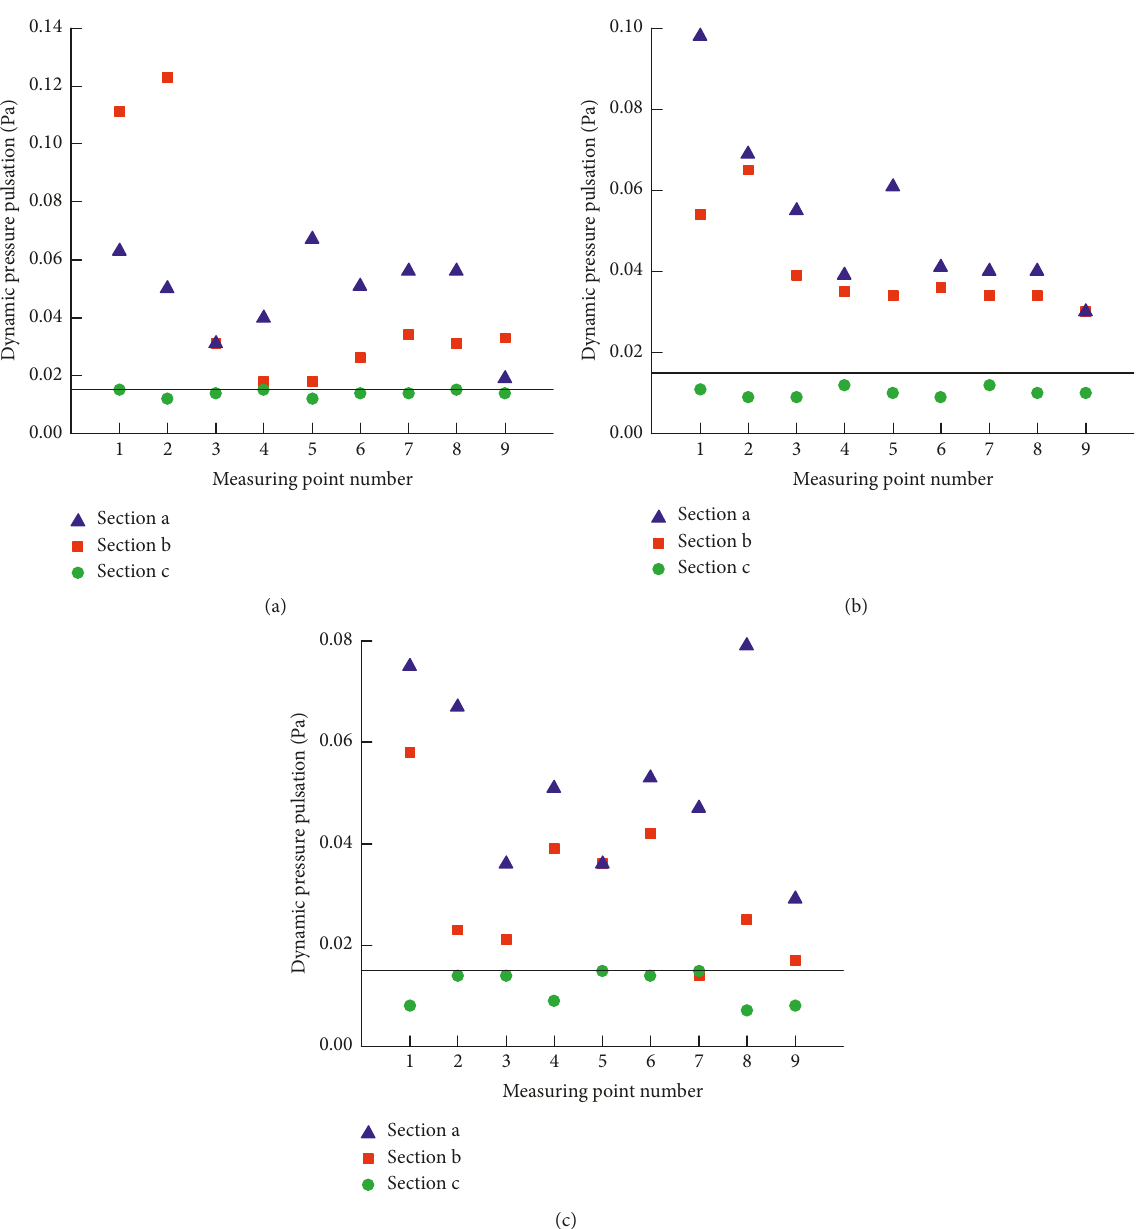
Figure 3: Dynamic pressure pulsation under different frequencies: (a) 30 Hz, (b) 40 Hz, and (c)